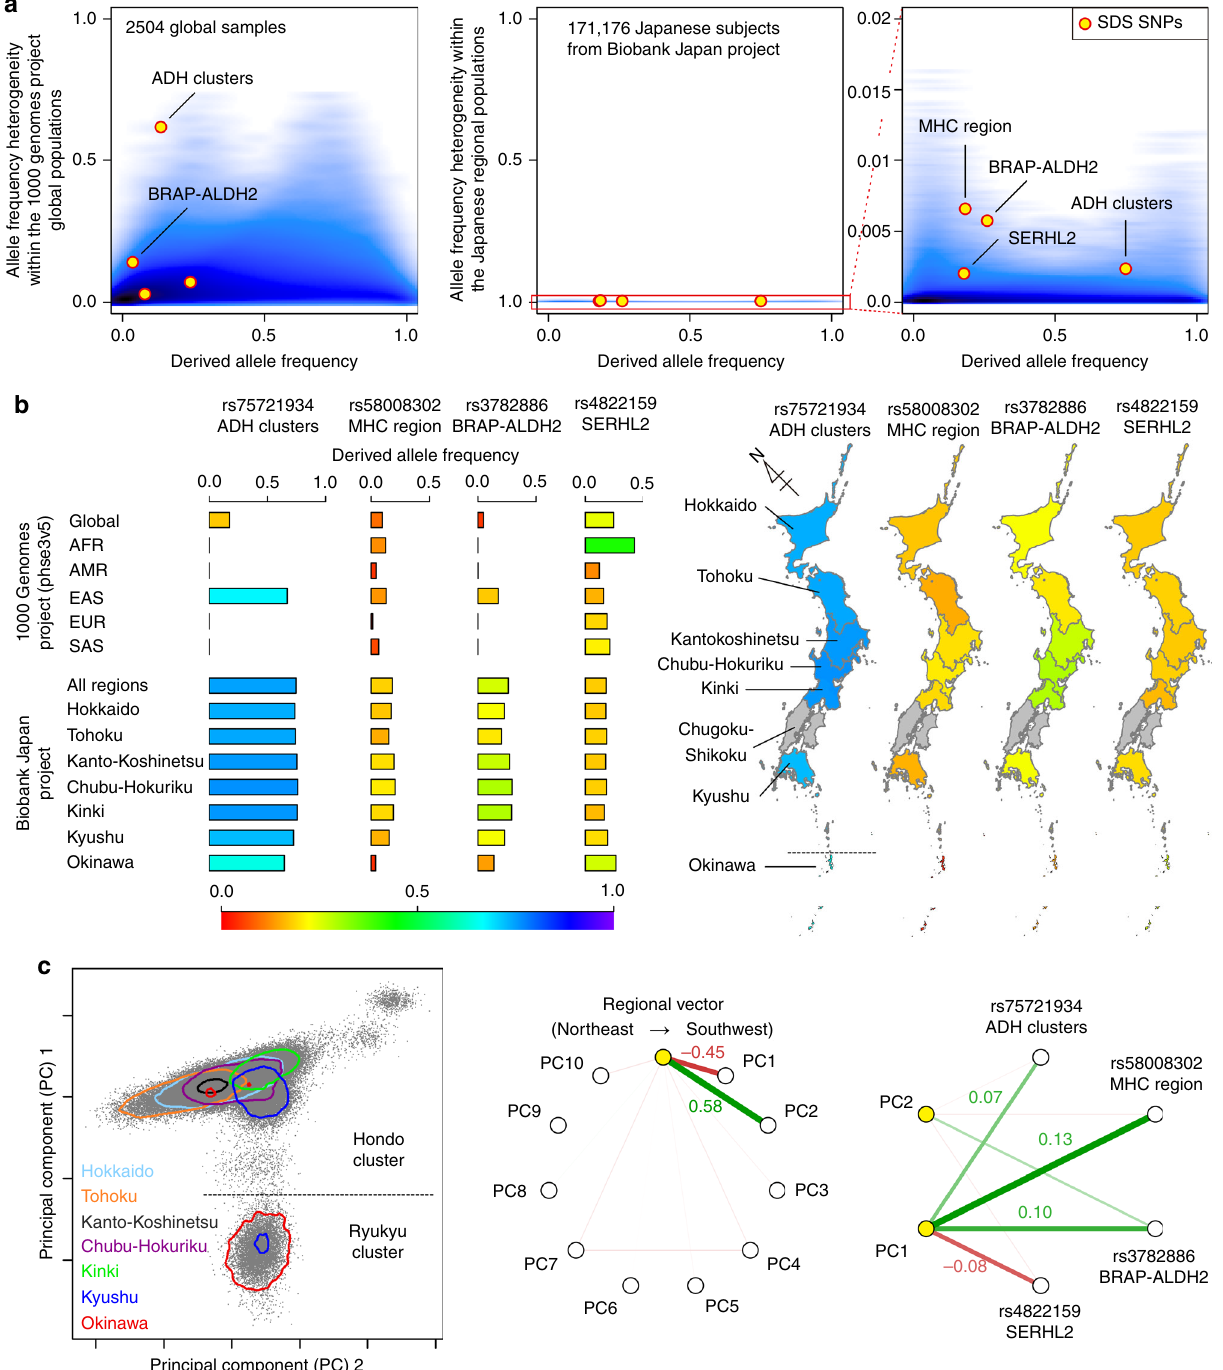
Fig. 4 Derived allele frequency heterogeneity of the SNPs with natural selection signatures. a DAF heterogeneity of the SNPs within subpopulations of the 1000 Genomes Project global subjects, or the regional populations of the Japanese subjects from the BBJ cohort. Strength of blue color corresponds to the density of the SNPs. Circles indicate the top SNPs identi fi ed by SDS, and the top SNPs with nominally signi fi cant enrichment of DAF heterogeneity are labeled ( P < 0.05). b DAF spectra of the four SNPs with genome-wide SDS selection signatures in each sub- or regional populations. DAF in each of the seven regions of Japan (Hokkaido, Tohoku, Kanto-Koshinetsu, Chubu-Hokuriku, Kinki, Kyushu, and Okinawa) are colored in the geographical map. We note that DAF in Chugoku-Shikoku was not available (colored in gray). c Correlations among the regional vector of Japan, PCs, and the SDS top SNP genotypes. PC1 separated the Japanese population into the two major clusters, Hondo and Ryukyu (left panel). Correlations between the regional vector and each of PCs (middle panel), and between top two PCs and each of the top SNP genotypes from the SDS analysis (right panel) are indicated. PC1 showed strong correlations with the regional vector and the SNP